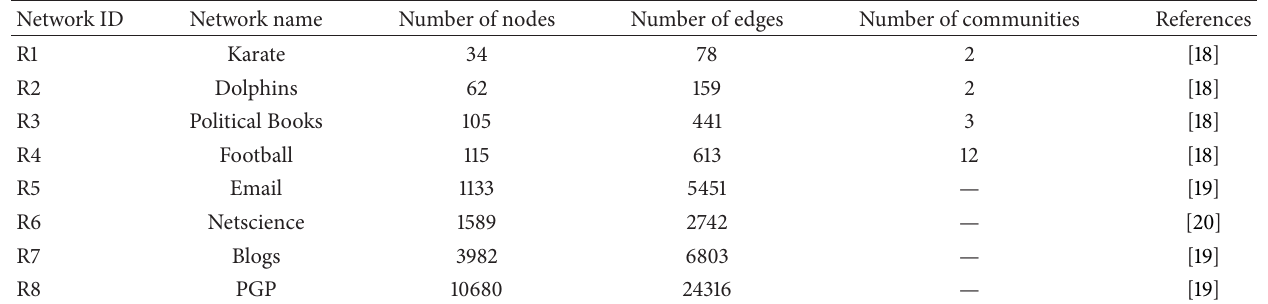
Table 4: The information of real networks.